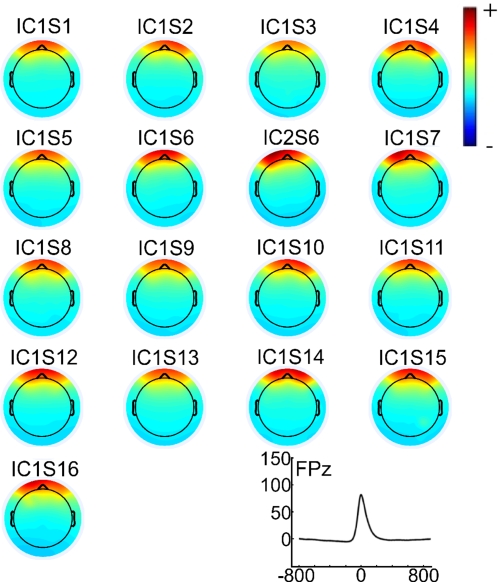
Topographic maps of the projection of blink components.Upper left: Grand average of activation of the blink-components back-projected to FPz. Right: Scalp topographies of the blink components (ic) for each subject (s). Note that ICA revealed for one subject (s6) two blink related components. The colour-map legend does not contain values since the ICA topographies represent arbitrary values.